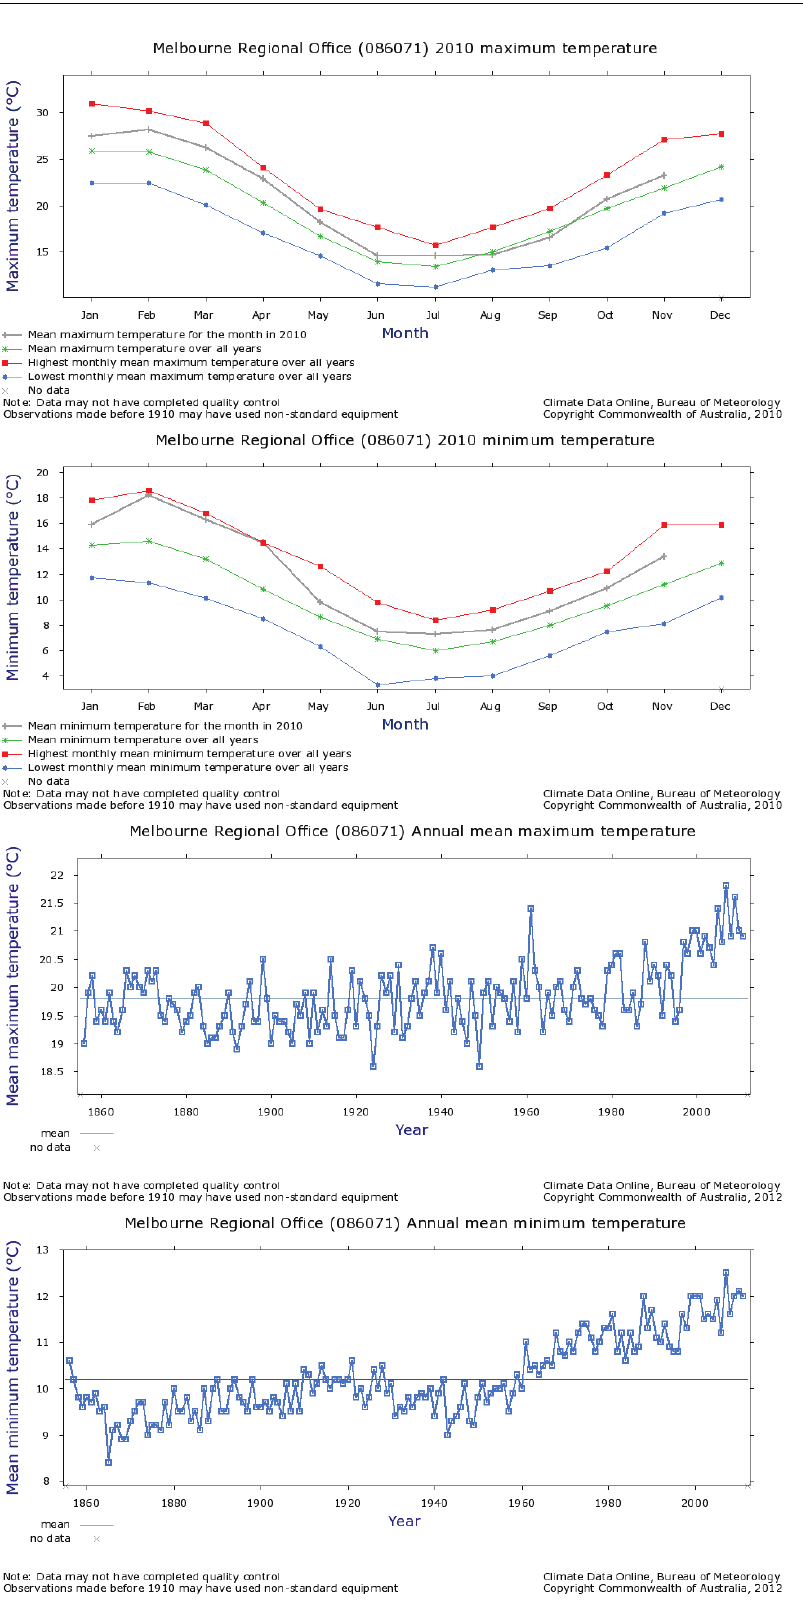
Figure 12. Australian Government Bureau of Meteorology temperature graphs for historical locations in Victoria, Aus-